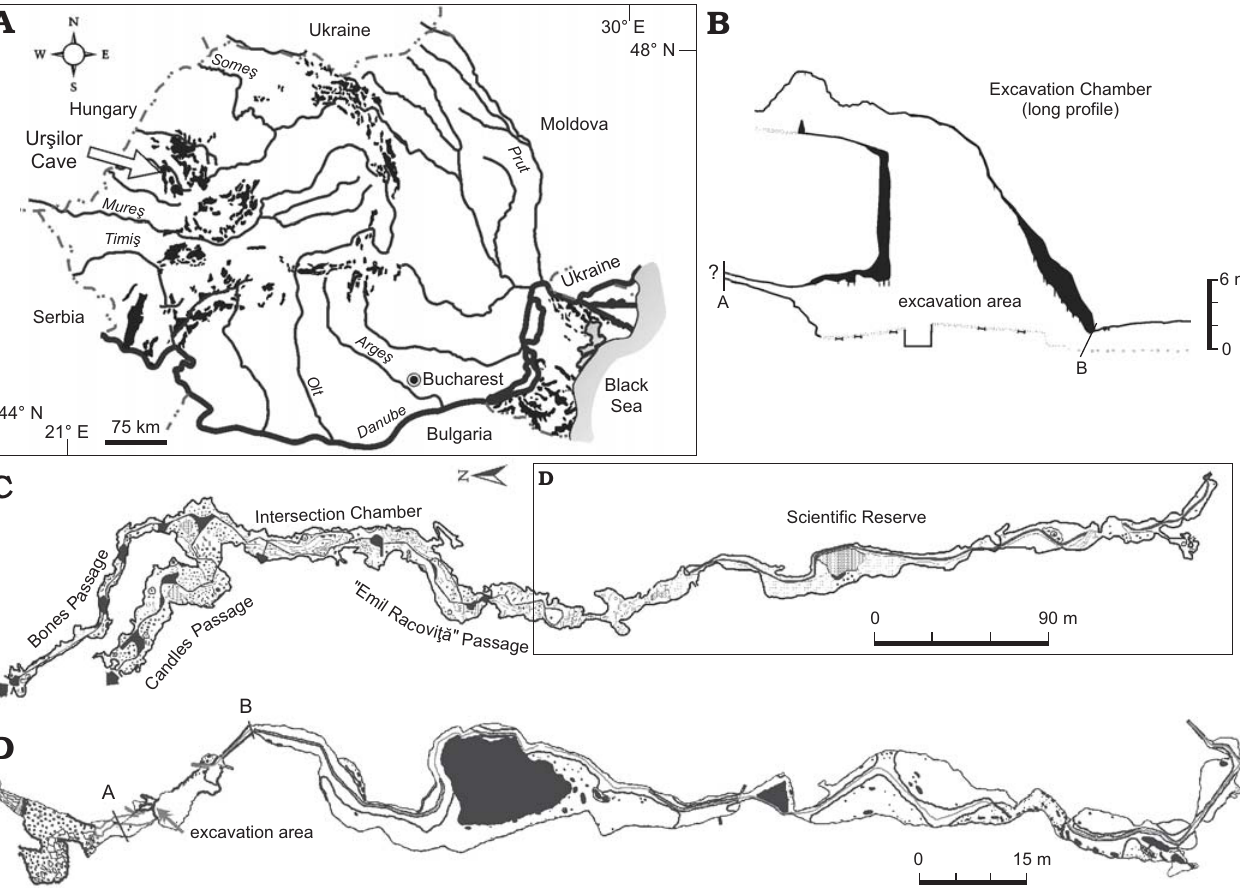
Fig. 1. Geographic localization ( A ) and plan ( C ) of Ur ş ilor Cave of Chi ş c ă u. B . Long profile (section) of the Excavation Chamber from the Scientific Reserve. D . Plan of the lower level of the cave (= Scientific